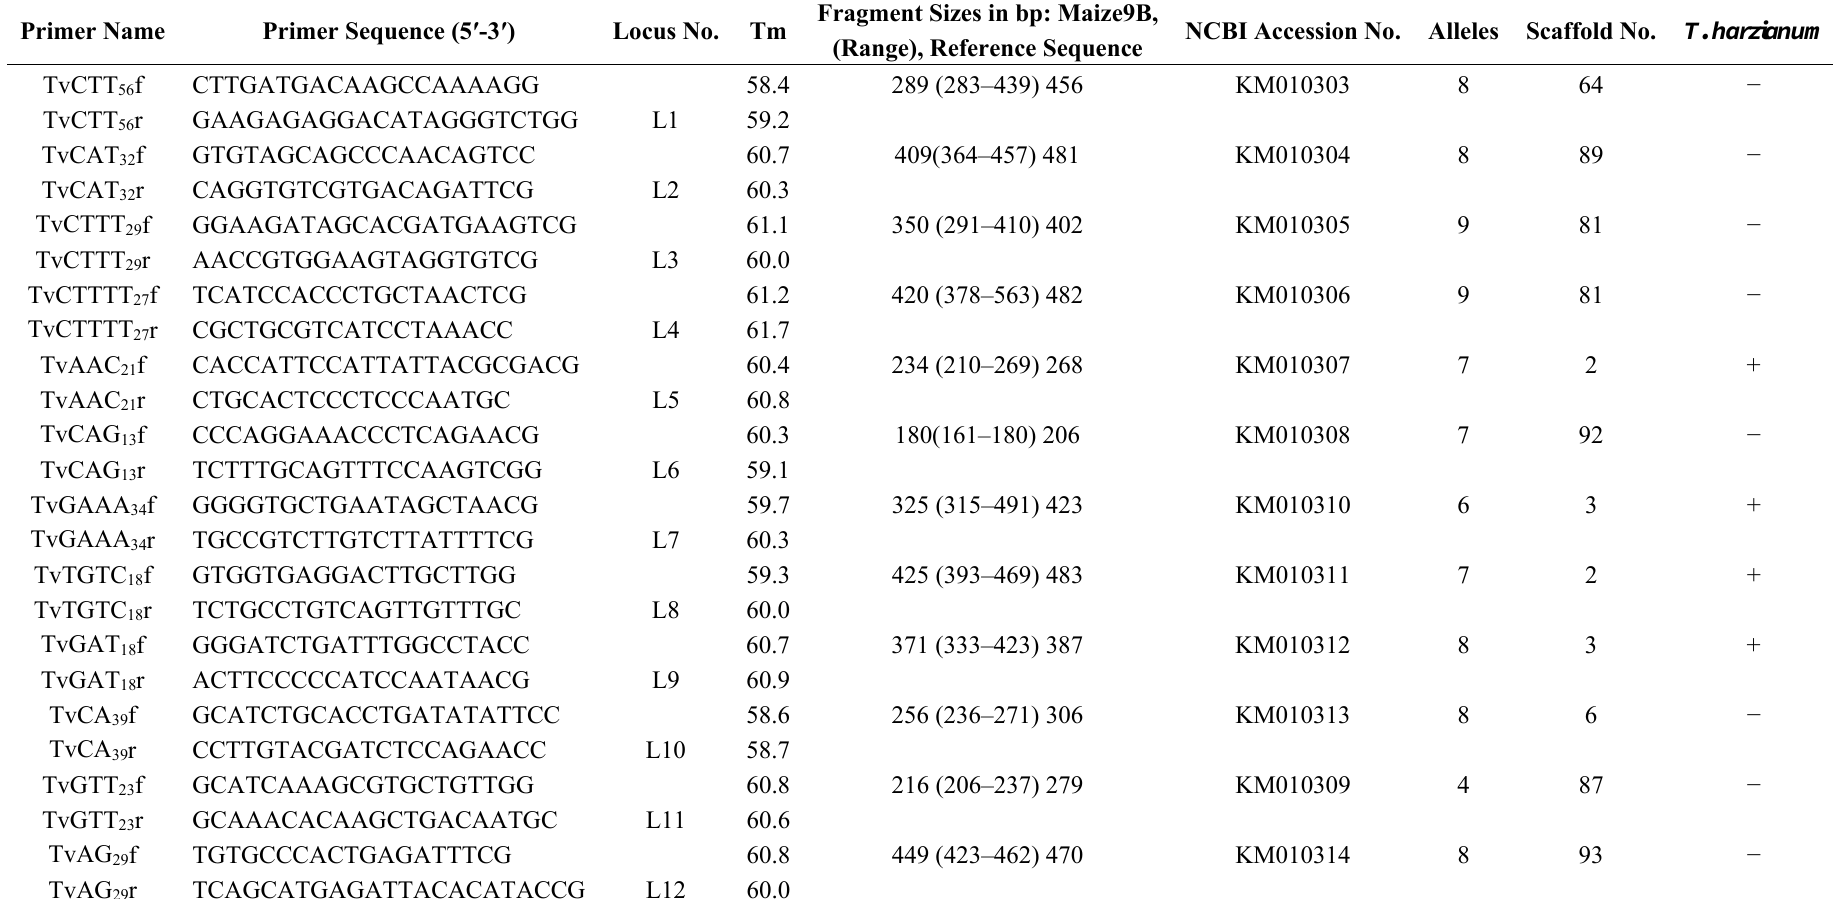
Table 1. PCR primer sequences for unique microsatellite loci in T. virens . Repeat numbers in primer names refer to the T. virens reference genome. “Fragment Sizes” were determined in isolate Maize9B; “Range” refers to the other strains analyzed in this study and “Reference Sequence” to the virtual fragment size in the reference genome. “Scaffold No.” marks the super contig from which loci were retrieved and the T. harzianum column shows which markers were transferable to T. harzianum . Primers for multiplex PCR are in